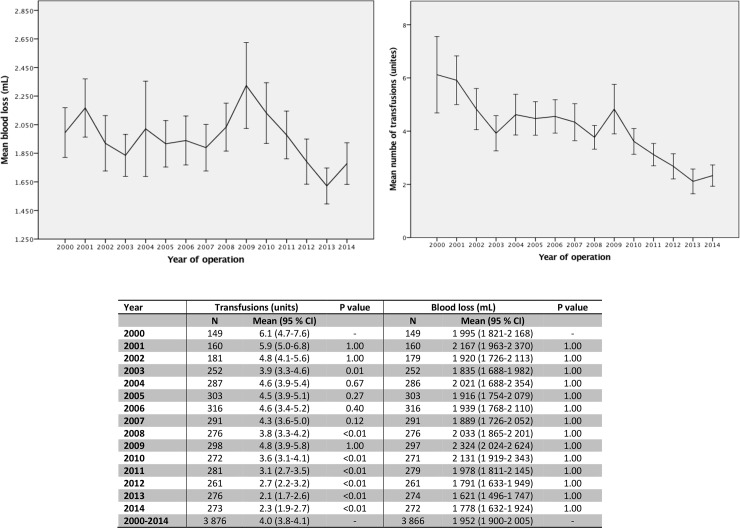
Development in transfusions and blood loss during 15-year follow-up period.Upper left: Mean blood loss (mL) per patient across time. Upper right Mean number of transfusions per patient across time. Lower: Development in transfusions and blood loss from January 1, 2000 to December 31, 2014. P value calculated with year 2000 as reference.